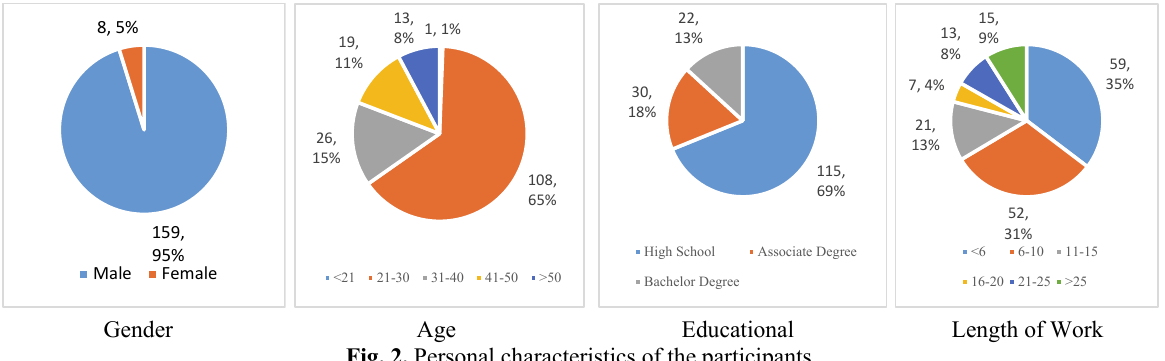
Fig. 2. Personal characteristics of the participants